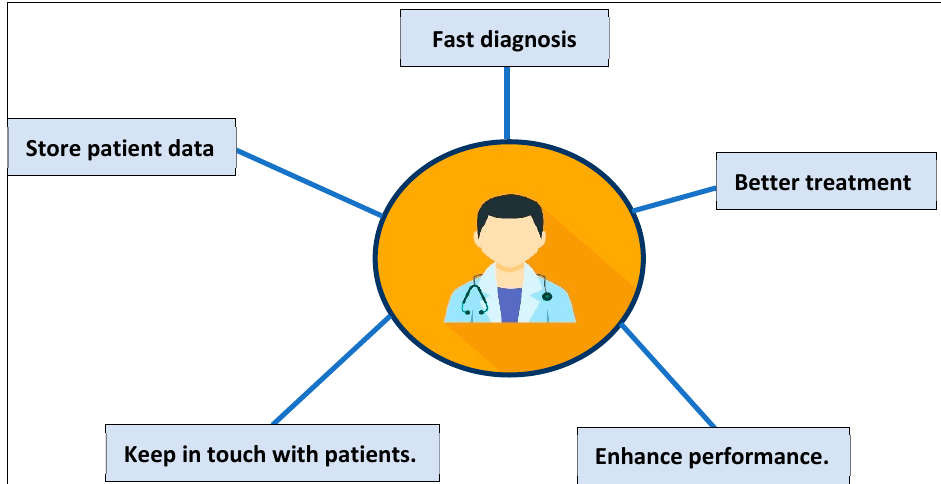
Figure 11. the benefit of smart healthcare to doctors. Figure 11. The benefit of smart healthcare to